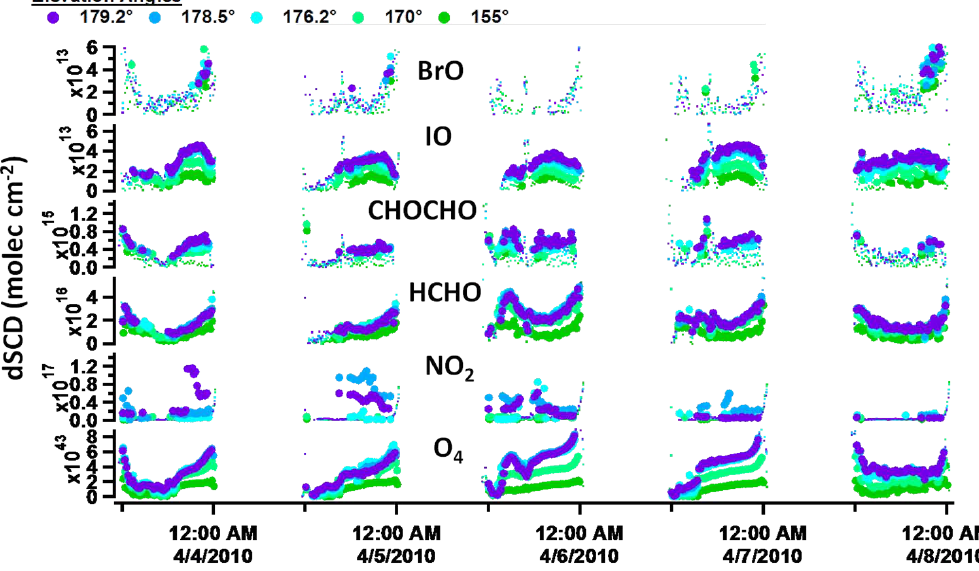
Fig. 10. Time series of the dSCDs for BrO, IO, CHOCHO, HCHO, NO 2 , and O 4 between 3 April and 8 April 2010 (times are in UTC). This plot is for viewing directions overlooking the open ocean. The large circles for each elevation angle represent statistically significant measurements, while the small dots are measurements that do not meet the significance criteria. The average fit errors from the WinDOAS analysis for these elevation angles were 7.9 × 10 12 molec cm − 2 , 2.2 × 10 12 molec cm − 2 , 1.1 × 10 14 molec cm − 2 , 1.9 × 10 15 molec cm − 2 , and 1.3 × 10 14 molec cm − 2 for BrO, IO, CHOCHO, HCHO, and NO 2 ,